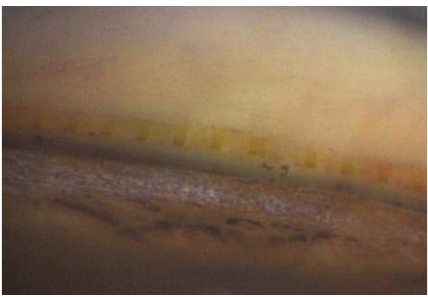
Figure 10: Stegmann Canal Expander in situ (gonioscopic view).